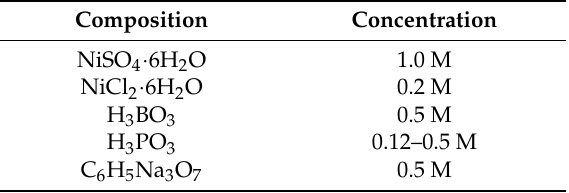
Table 1. Bath composition and concentration for Ni-P alloy